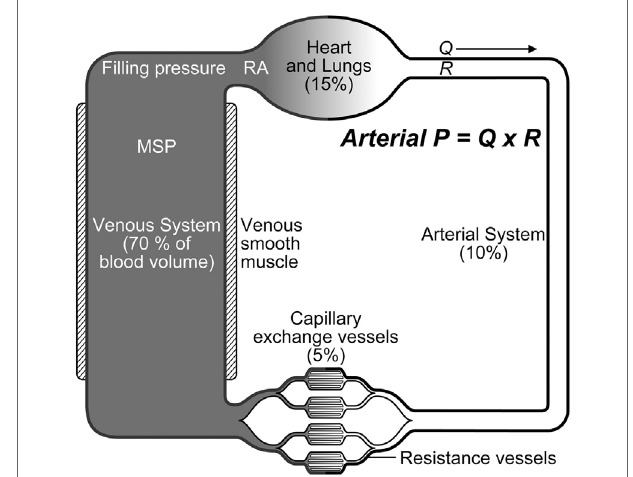
Figure 1 | Blood is unevenly distributed throughout the systemic circulation. The large and small veins contain approximately 70% of the blood volume. Arterial pressure (P) is determined by blood flow (Q) and systemic vascular resistance (R); MSP, mean systemic pressure; RA, right atrium.